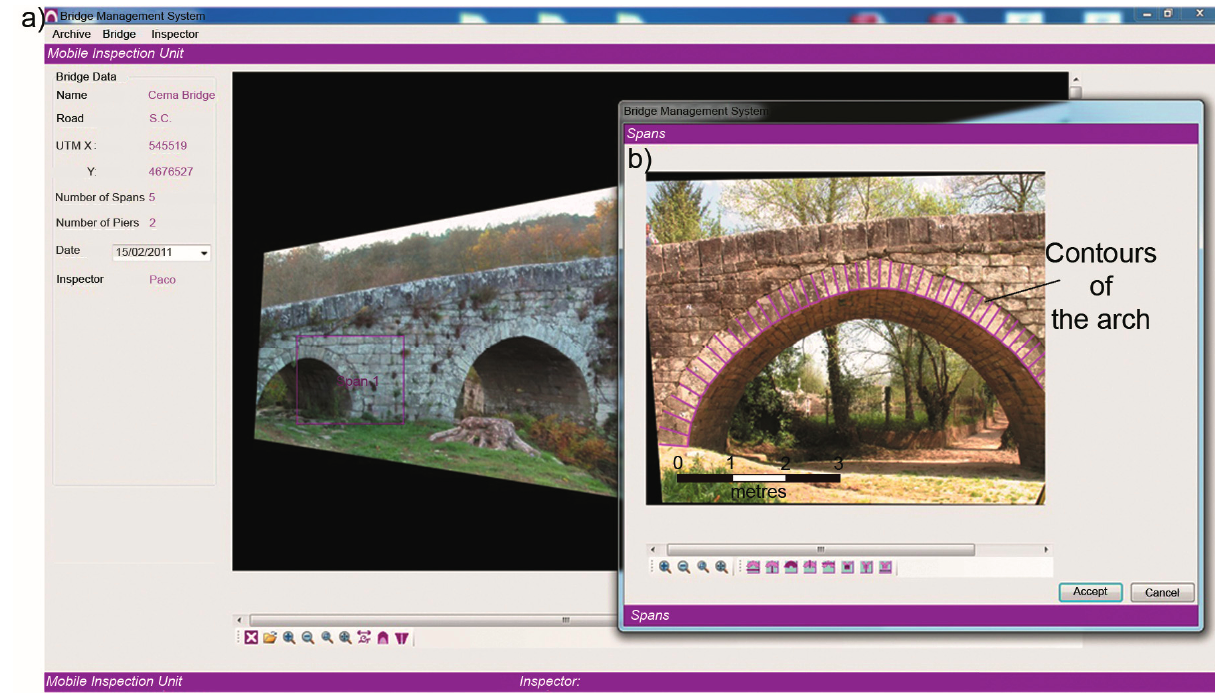
Figure 2. ( a ) Visualization of the application of image rectification, allowing geometric parameters stored in the database to be acquired. ( b ) In the rectified image of the arch, note the contours of the arch to be input in the software for the analysis of structural